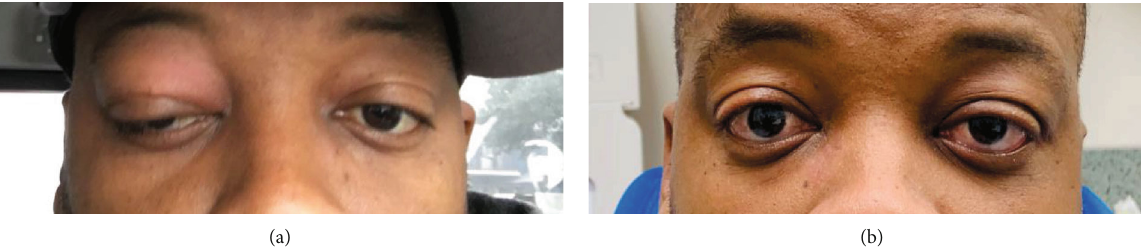
Figure 1: (a) Patient with orbit in fl ammation after sugery and multiple rounds of steroids prior to radiation. (b) Follow-up: 3 months after radiation with resolution of in fl ammation and symptomatic